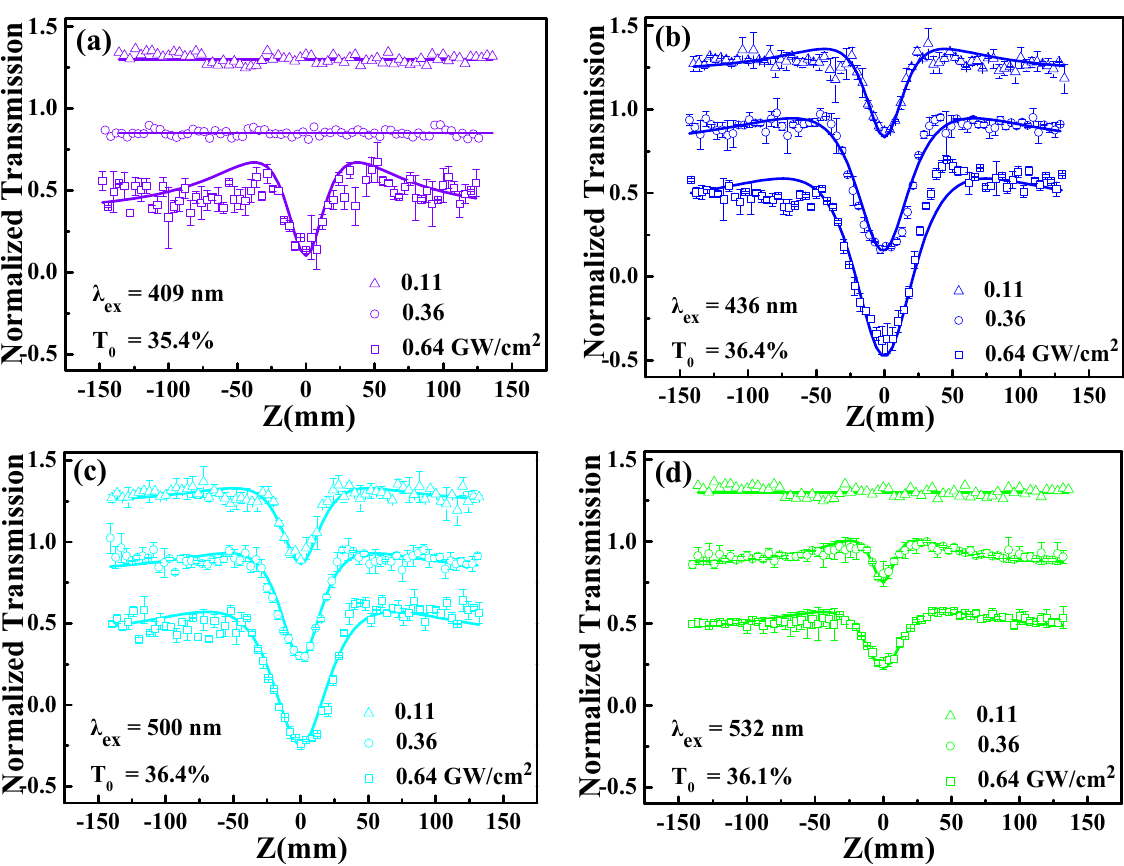
Figure 4. Normalized transmission of Ag@Ti 3 C 2 dispersion for open aperture Z-scan at the wavelength of ( a ) 409 nm, ( c ) 500 nm, and ( d ) 532 nm. ( b ) Ag@Ti 3 C 2 and Ti 3 C 2 nanosheet dispersion open aperture Z-scan data for comparison.